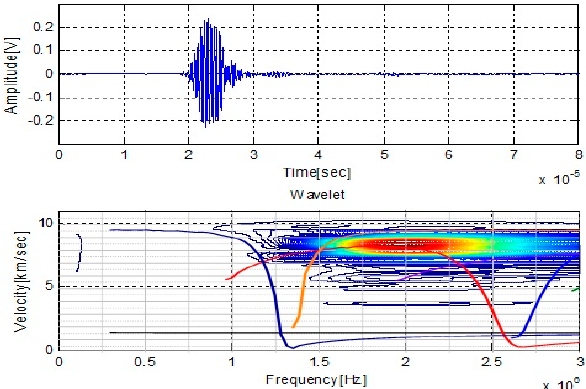
Figure 2. Wavelet analysis of experimental signal for mode verification.